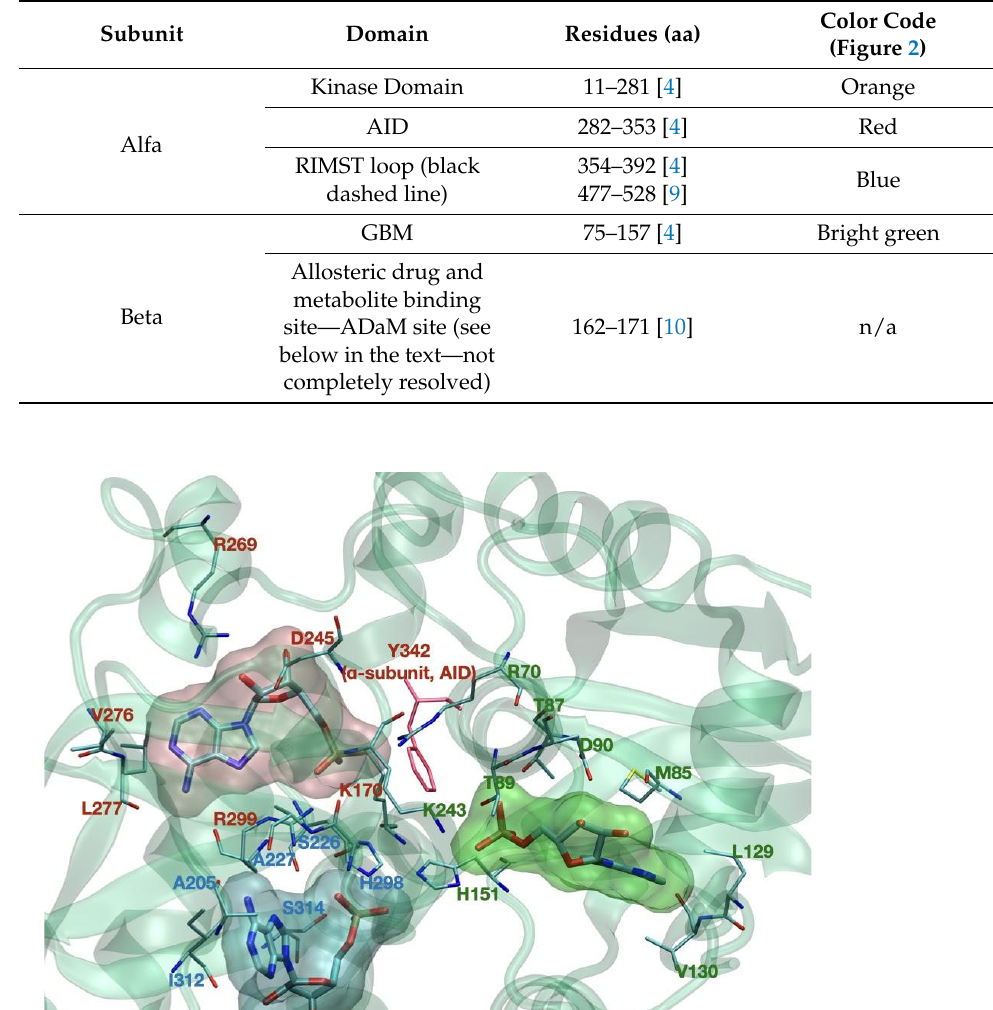
Table 1. Residue numbers for each highlighted domain.